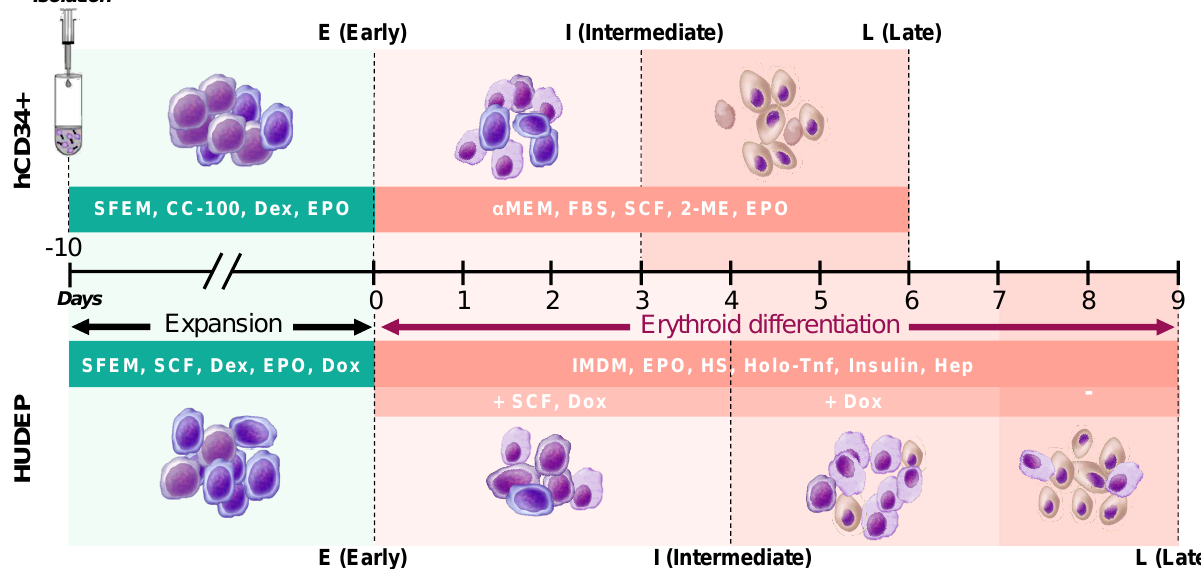
Figure 1. Experimental design. A schematic diagram showing cell-type-specific culture stages, conditions, and timelines. hCD34+: primary human peripheral-blood-derived CD34+, HUDEP: cell lines HUDEP-1 and HUDEP-2, SFEM: Stem Span SFEM II, α MEM: Minimum Essential Medium Eagle with alpha modification, IMDM: Iscove’s Modified Dulbecco’s Medium, FBS: fetal bovine serum, SCF: stem cell factor, CC-100: StemSpan CC100, Dexa: dexamethasone, Dox: doxycycline, EPO: erythropoietin, HS: human serum, Holo-Tnf: holo-transferrin, Hep: heparin, 2-ME: